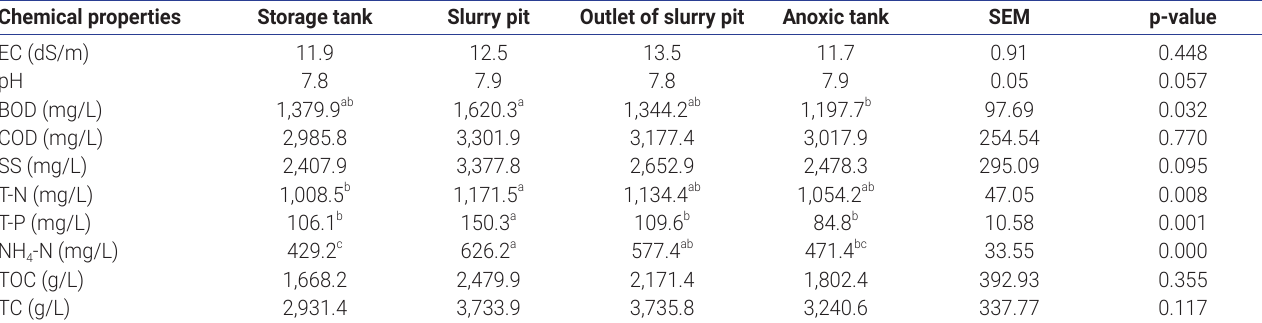
Table 3. Chemical properties of the recirculation liquid based on the treatment process equipped within the continuous pit recirculation system Chemical properties